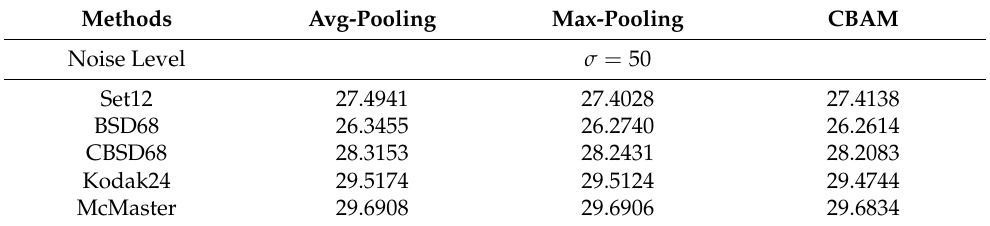
Table 7. PSNR (dB) on Set12, BSD68, CBSD68, Kodak24, and McMaster using different pooling methods.